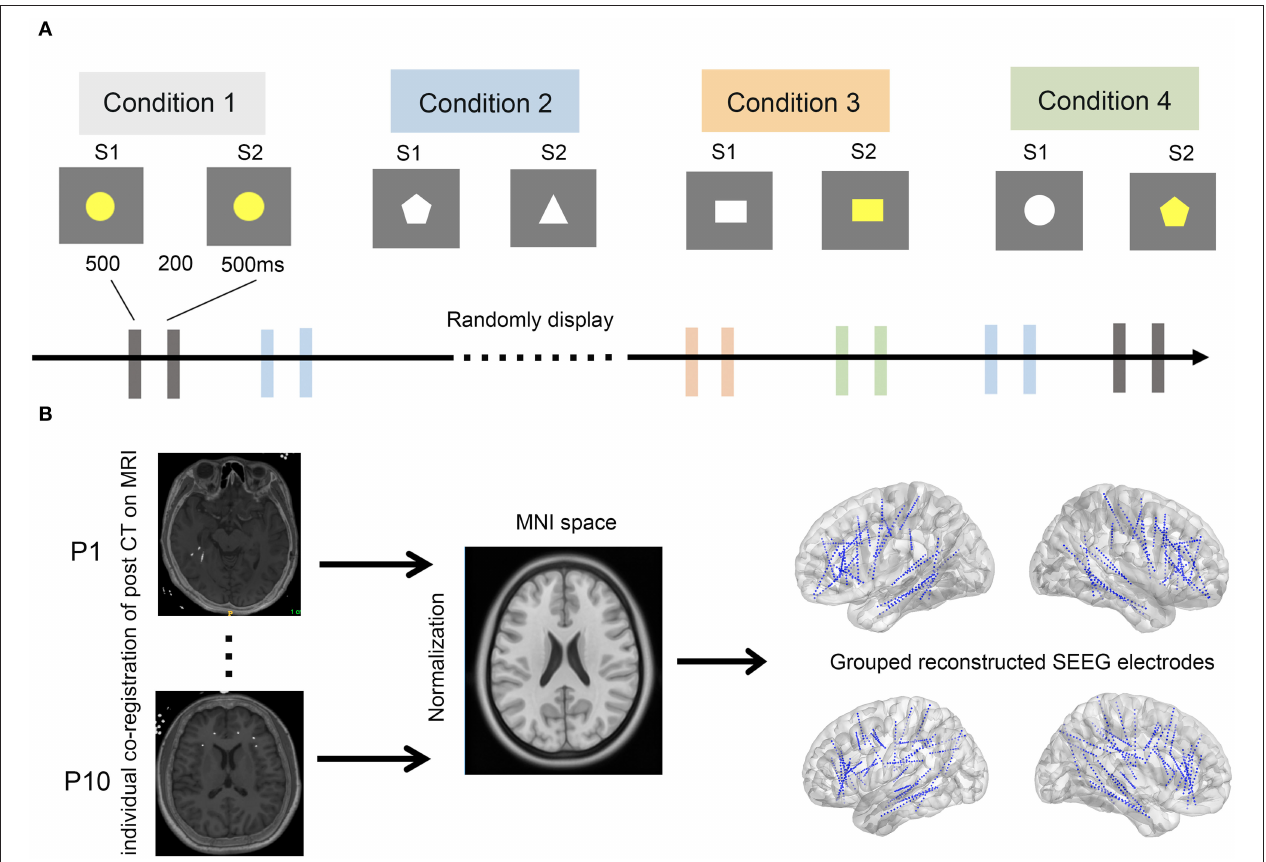
FIGURE 1 | The experimental paradigm and pipeline of SEEG electrode reconstruction. (A) The experimental paradigm. Four conditions, including conditions 1–4, were randomly displayed every 5s. A stimulus pair of stimulation 1 (S1) and 2 (S2) was sequentially presented in each condition. Of note, S1 and S2 were assigned as congruent, irrelevant incongruent, relevant incongruent, and conjunction incongruent in conditions 1–4, respectively. (B) Pipeline of SEEG electrode reconstruction. All implanted electrodes in all subjects were overlaid on a standardized brain in MNI space. Post-implantation CT images were individually co-registered to the pre-implantation MRIs (left), which were further normalized to standard MNI space (middle). The coordinates of each electrode were therefore calculated in the MNI space. Finally, all SEEG electrodes of the 10 patients were reconstructed and displayed over the three-dimensional brain in the MNI space (right).